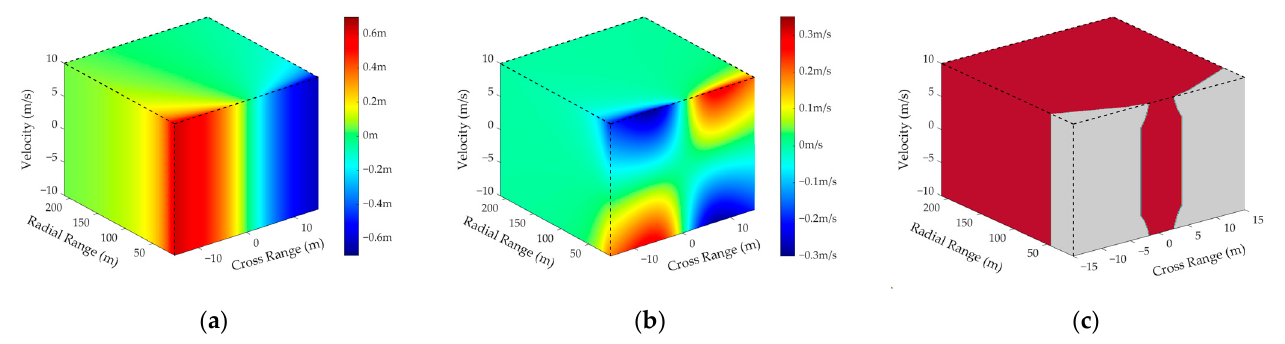
Figure 8. The simulation results of Test 3. ( a , b ) display the range and velocity deviations. ( c ) represents radar detection scenario, including effective region (red) and ineffective region (gray).